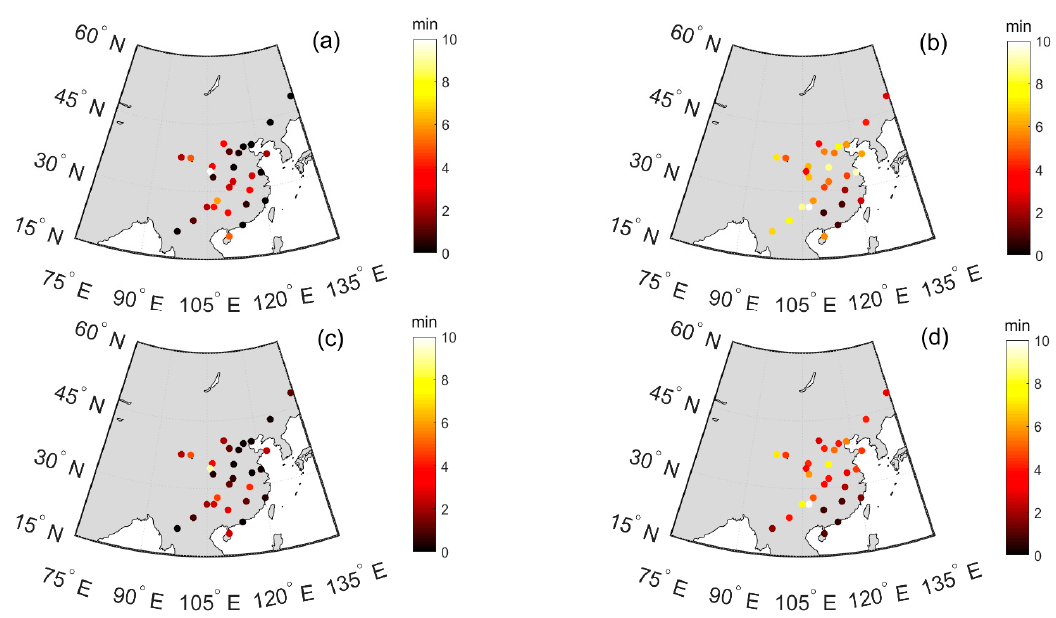
Figure 11. The improvement of average convergence time of static PPP with SHAtropE model for GPS-only and BDS-only solutions compared to UNB3m and GPT3 models. ( a ) UNB3m—SHAtropE for GPS-only PPP, ( b ) UNB3m—SHAtropE for BDS-only PPP, ( c ) GPT3—SHAtropE for GPS-only PPP, ( d ) GPT3—SHAtropE for BDS-only PPP.